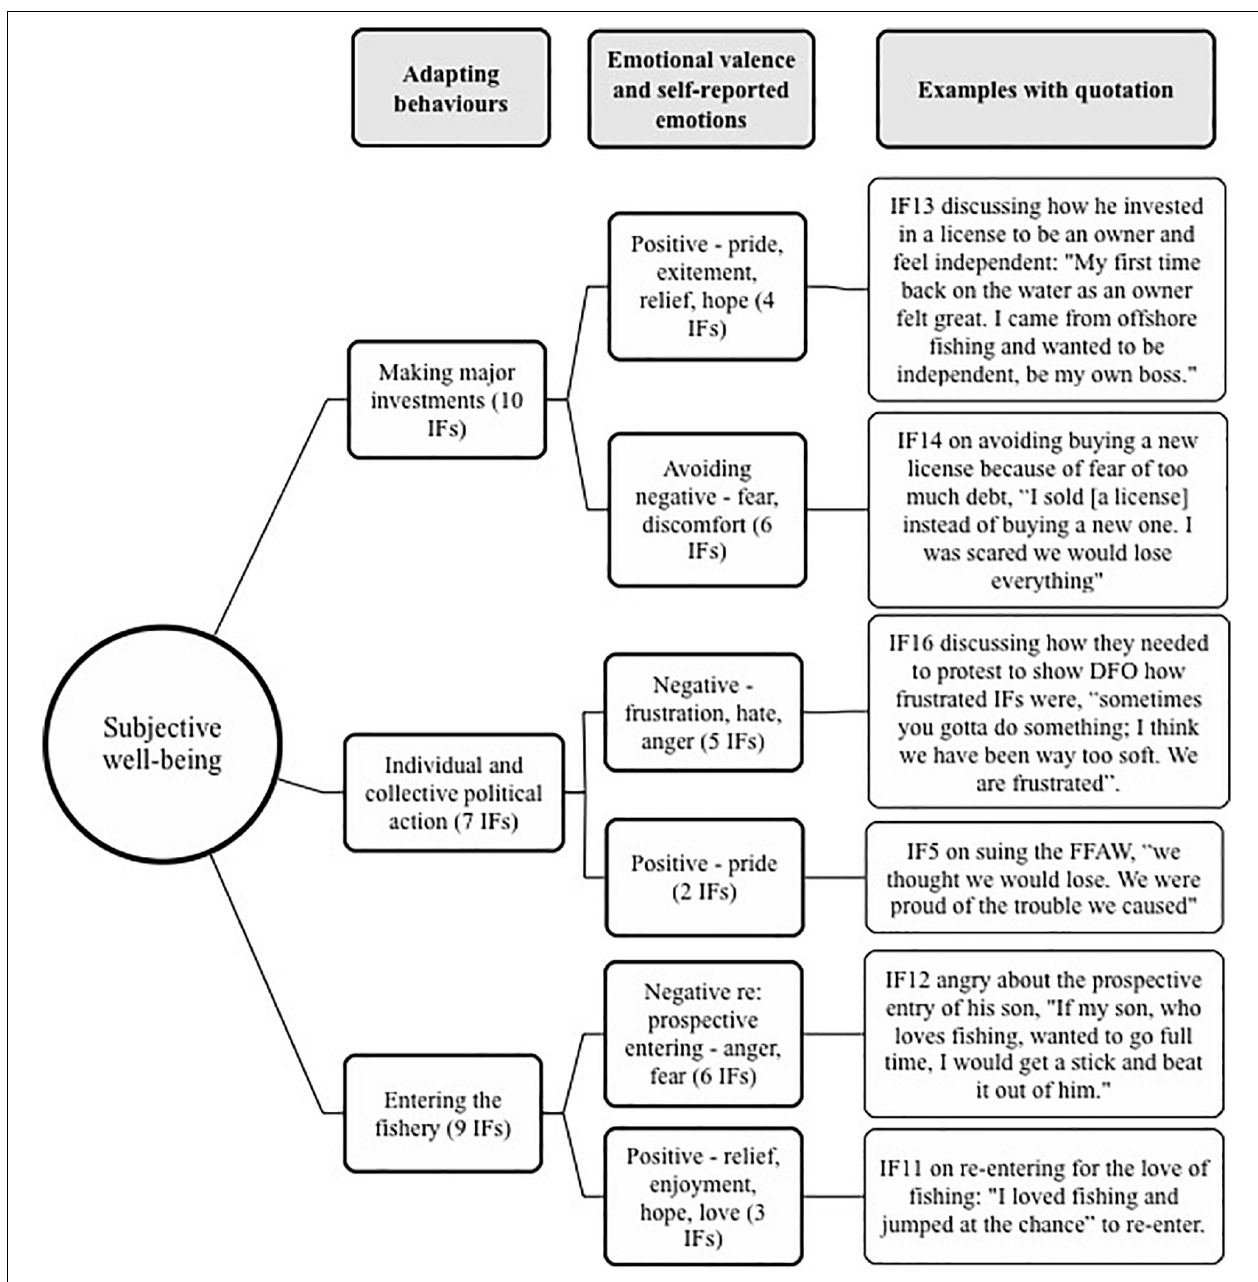
FIGURE 6 | Emotions as subjective well-being goals for adapting behavior.